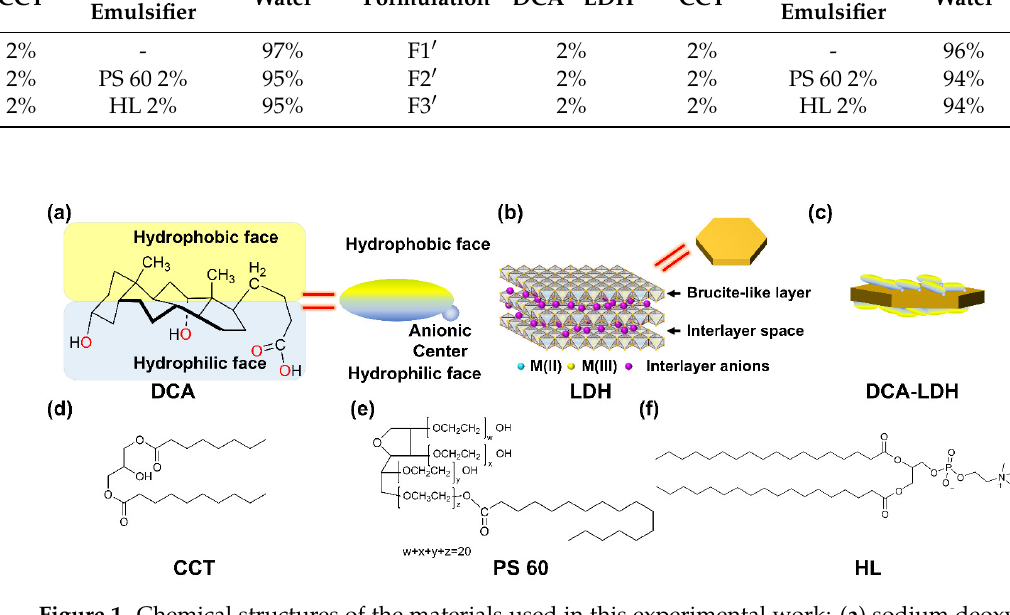
Figure 1. Chemical structures of the materials used in this experimental work: ( a ) sodium deoxy- cholic acid (DCA), ( b ) layered double hydroxide (LDH), ( c ) DCA adsorbed on LDH (DCA-LDH), ( d ) Caprylic/capric triglyceride (CCT), ( e ) polysorbate 60 (PS 60), ( f ) hydrogenated lecithin (HL). Table 1. Content (in % wt/wt) of DCA or DCA−LDH; CCT; and co-emulsifier in each formulation.